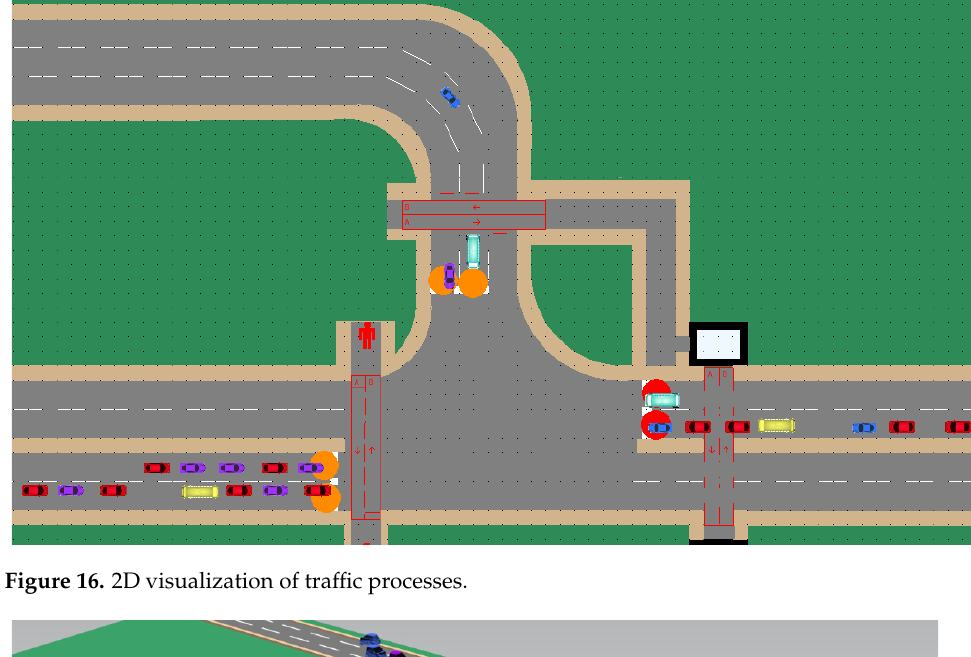
Figure 16. 2D visualization of traffic processes.